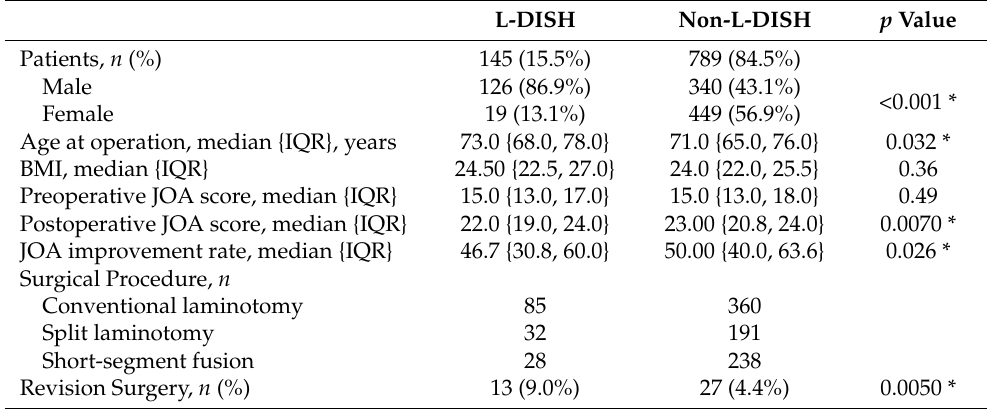
Table 1. Differences in background and clinical data between patients with and without L-DISH. L-DISH Non-L-DISH p Value Patients, n